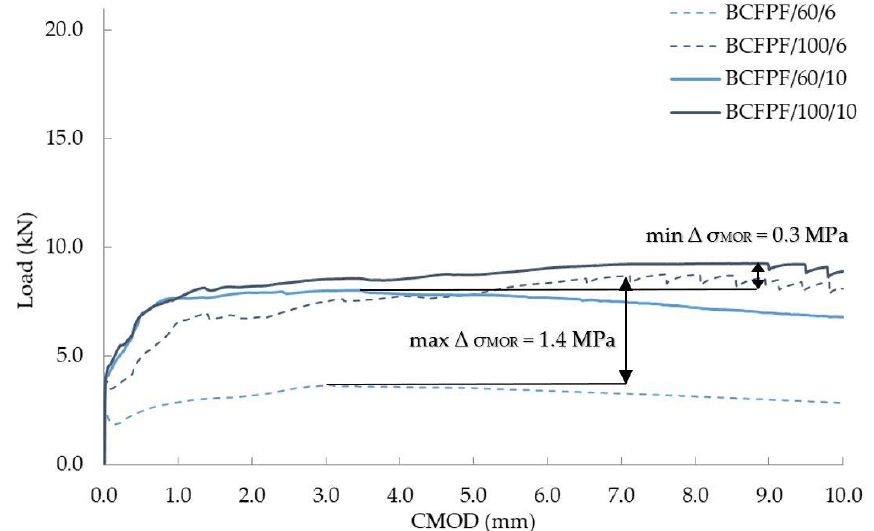
Figure 11. Load—CMOD (crack mouth opening displacement) relationship graphs showing the influence of fiber length on the obtained σ MOR stress values for fiber-reinforced soil-cement with a 400/1.6 matrix.